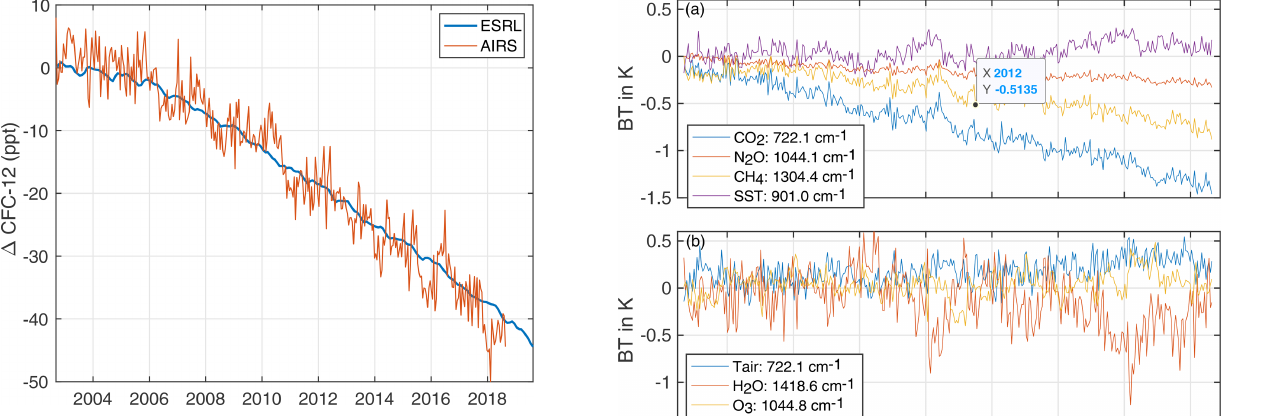
Figure 17. AIRS CFC-12 retrieved anomaly compared to the NOAA ESRL Northern Hemisphere anomaly. Note that a 40ppt trend in CFC-12 corresponds to about 0.11K in brightness temper- ature for the channel with the highest CFC-12 Jacobian.